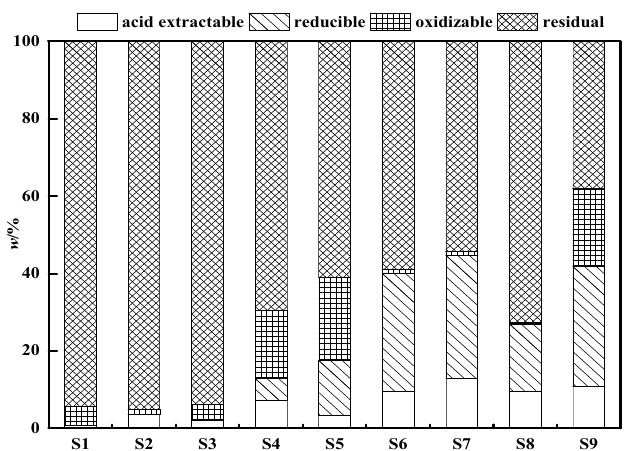
Figure 2. Sequential extraction of Sb from primary-explosives-contaminated